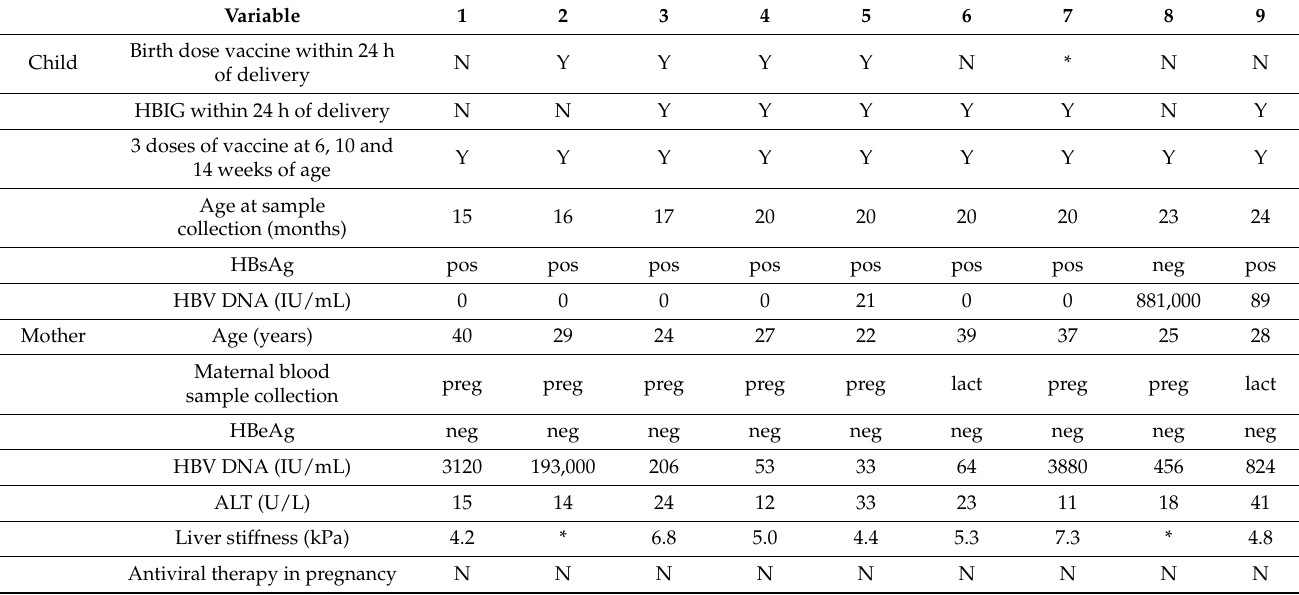
Table 4. Characteristics of nine children with active HBV